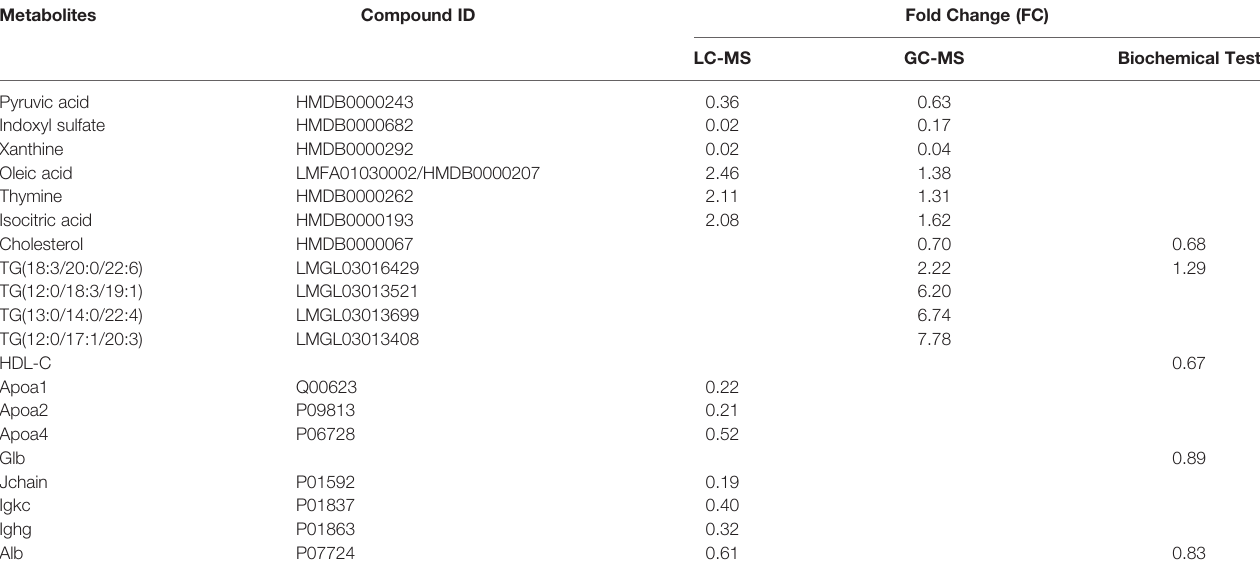
TABLE 2 | The Consistency of DEMs and DEP with different detection